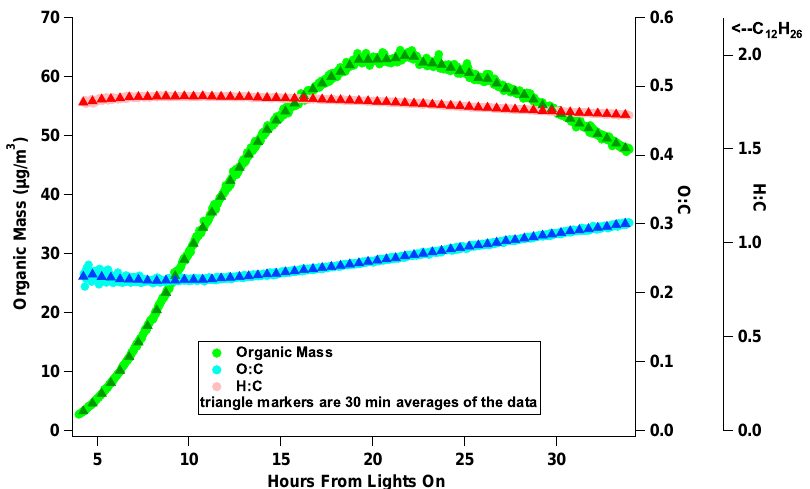
Fig. 1. Total organic aerosol mass and O:C and H:C elemental ratios for experiment 2. The C 2 H + spectra due to its interference with the large signal from the N +